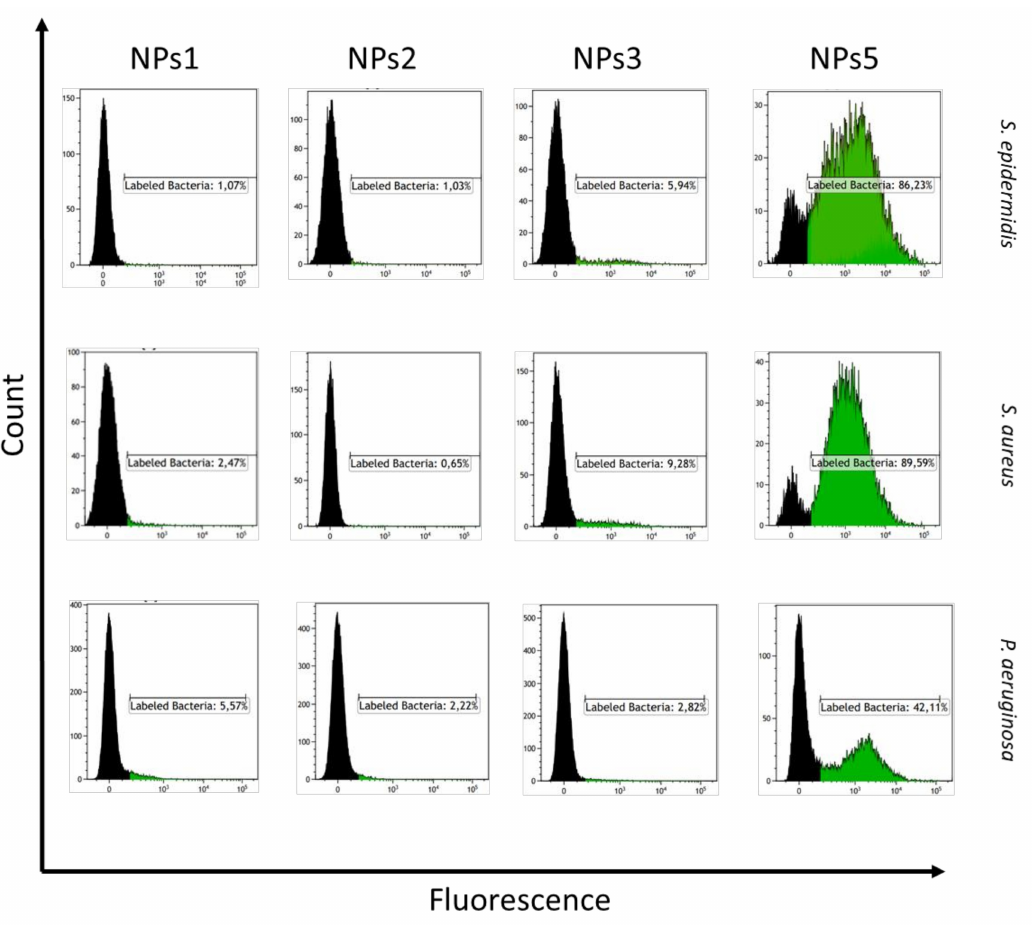
Figure 2. Flow cytometry analyses. Cytofluorometric profiles representing the distribution of bacterial cells labeled with NPs.